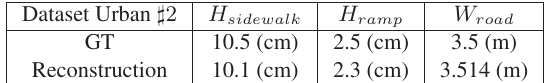
Table 1: Accuracy evaluation of the ground surface reconstruc- tion with respect to ground truth (GT) data for Urban ♯ 2 .